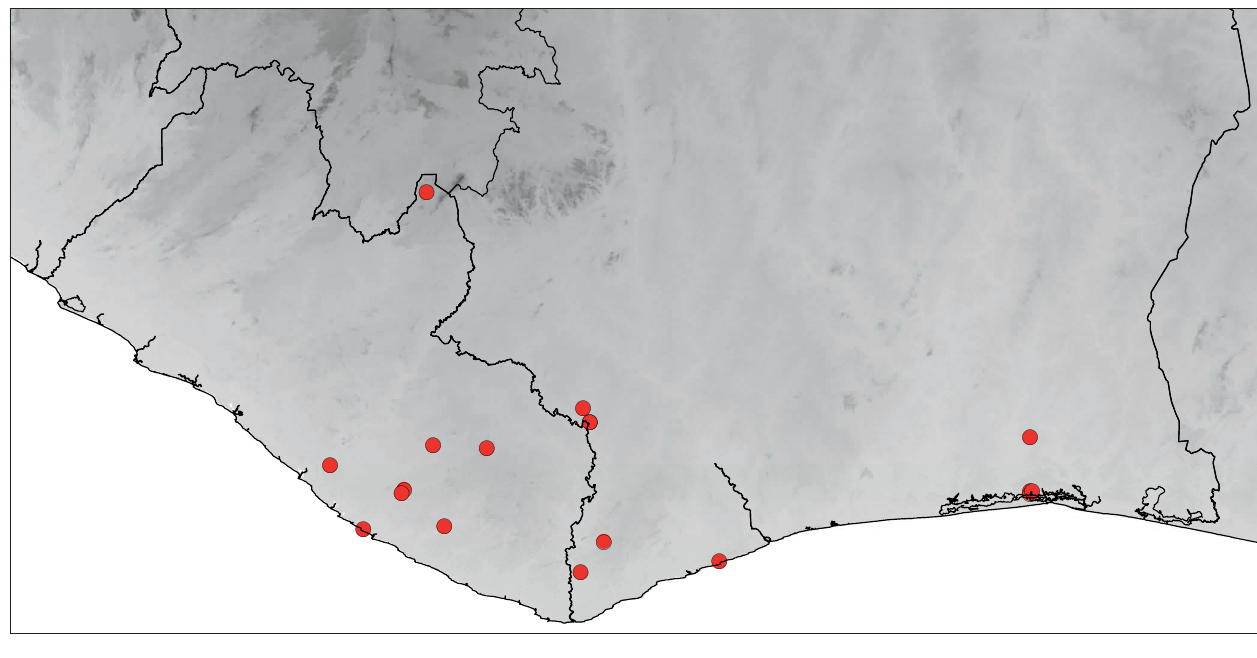
► Figure 15 – Rhigiocarya racemifera . A . Leaf with detail of leaf base beneath. B . Androecium. C . Fruit cut lengthwise. D . Fruit in transverse cut. B from de Wit 8299 (WAG); C–D from Leeuwenberg 6320 (WAG). A drawn by Marjolein Spitteler; B–D drawn by Hans de